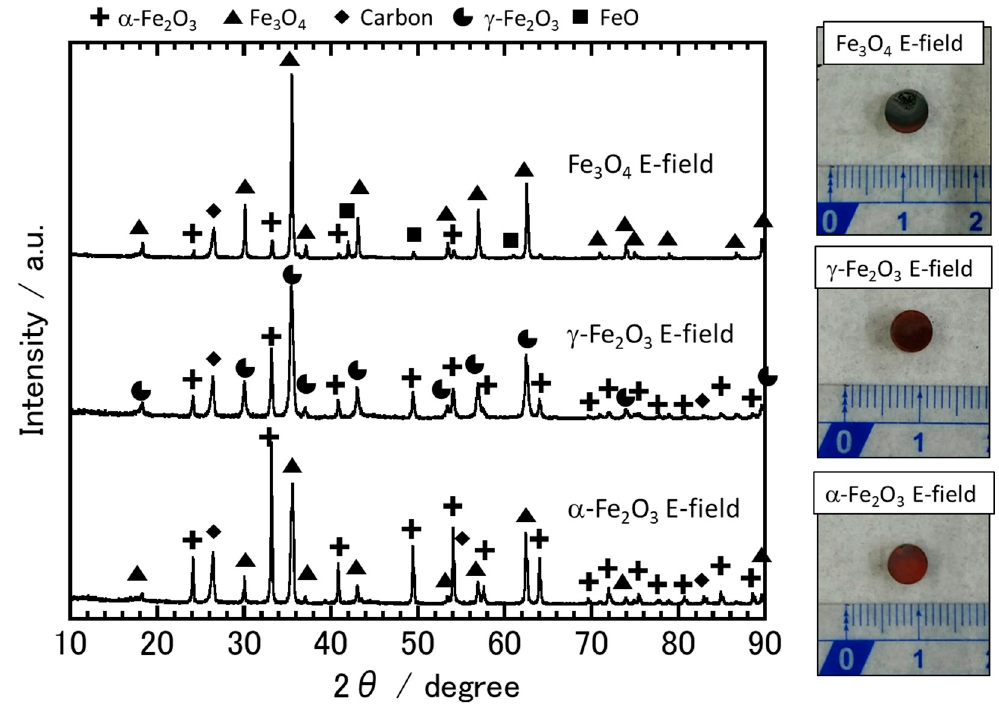
Figure 5. XRD results and photographs of the sample after irradiation with E-fields.